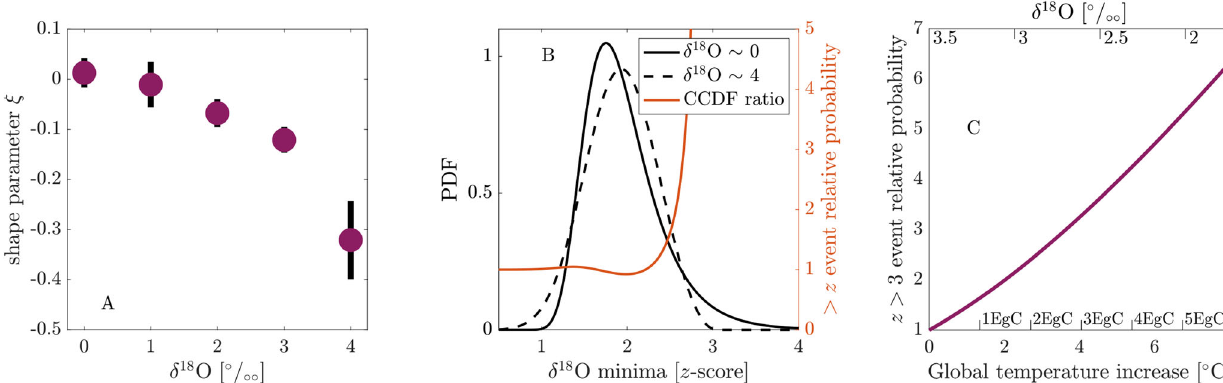
Fig. 3 The shape of the extremes ’ distribution changes with the baseline climate state. A Generalized extreme value (GEV) distribution ’ s shape parameter ξ as a function of baseline climate state. Compare with analogous fi gures, including δ 13 C and maxima in δ 18 O in Fig. S1. Error bars are bootstrap median absolute deviation. B GEV probability density function with the parameters from mean δ 18 O = 0 ± 0.5 (solid black line) and 4 ± 0.5 (dashed black line) from ( A ). The orange line is the ratio of these two distributions' complementary cumulative density functions, indicating e.g., that δ 18 O extremes > 2 2 standard deviations below the mean are > 3× more likely when δ 18 O ~ 0 than when δ 18 O ~ 4. C Relative likelihood of δ 18 O extremes > 3z (three standard deviations below the mean) for different mean δ 18 O values (upper x -axis) compared to present (mean δ 18 O = 3.5 ± 0.25). For instance, such extremes are ~5× more likely when δ 18 O = 2 ±